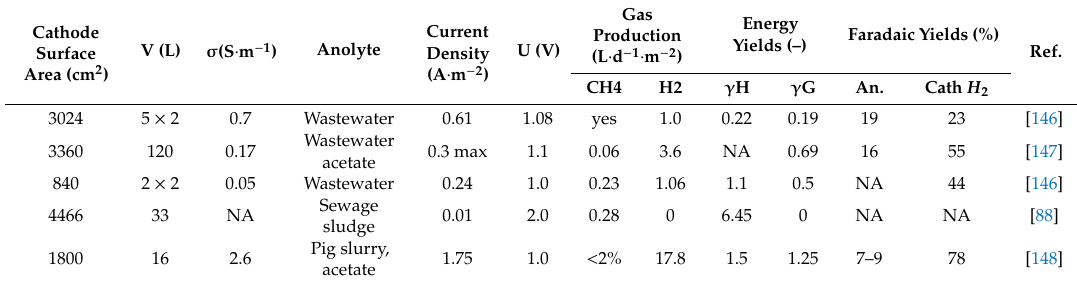
Table 2. Characteristics of microbial electrolysis cell (MEC) pilots with volumes of at least several liters. Cathode Surface Area (cm 2